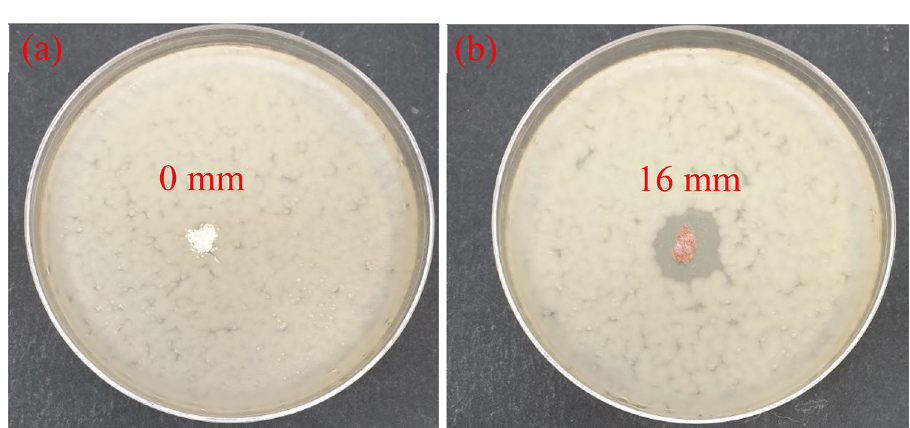
Figure 11. Bactericidal properties of ( a ) raw HNTs and ( b ) HNTs functionalized by iron oxide and silver nanoparticles towards the gram-positive B. subtilis